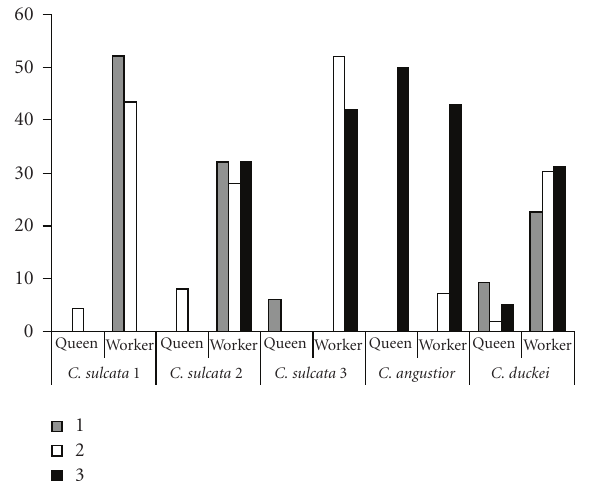
Figure 3: Relative age based on the pigmentation of the 5th gastric sternite of queens and workers in species of genus Clypearia . (1) Without pigmentation or incipient; (2) little brown; (3) dark brown. Table 3: Discrimination between queens, workers, and intermedi- ate females in all analyzed colonies of genus Clypearia after forward stepwise discriminant function analyses. Colony